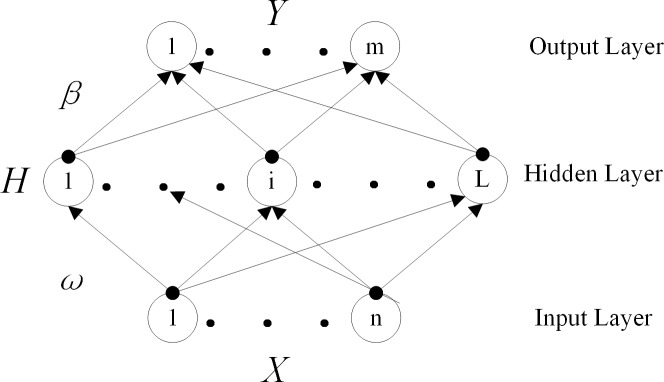
Structure of ELM.